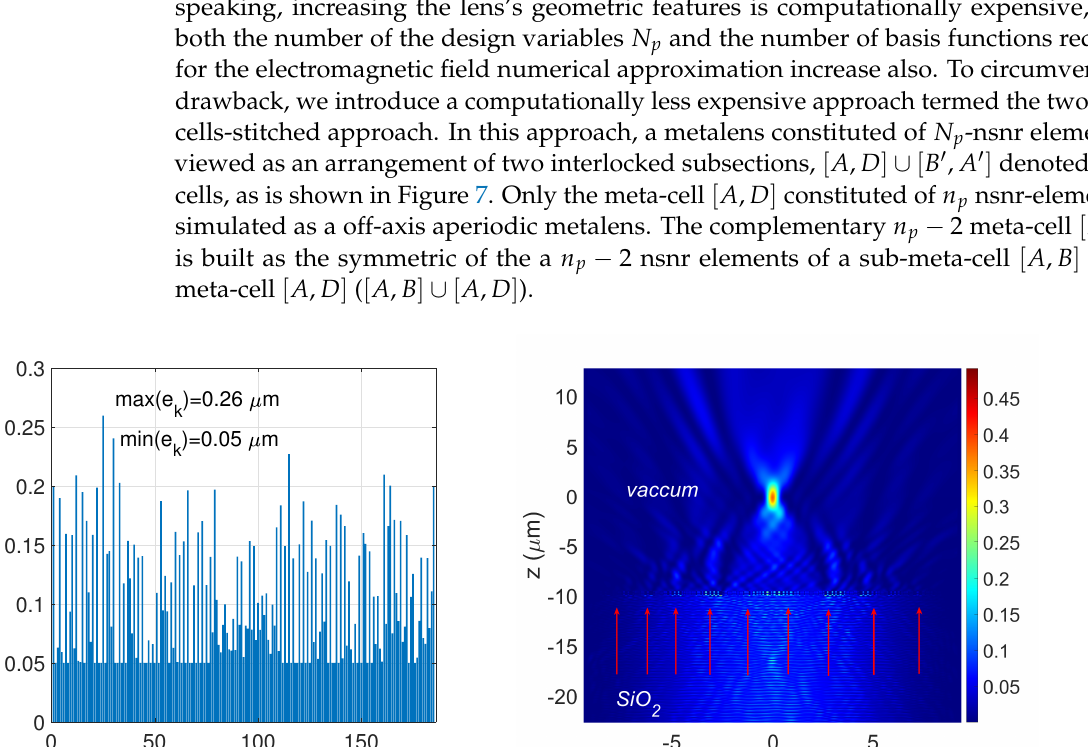
(cid:82) | H inc ( x , z s ) | 2 dx ; ( b ) | H y ( x ,0 ) | 2 / (cid:82) | H inc ( x , z s ) | 2 dx y y I I